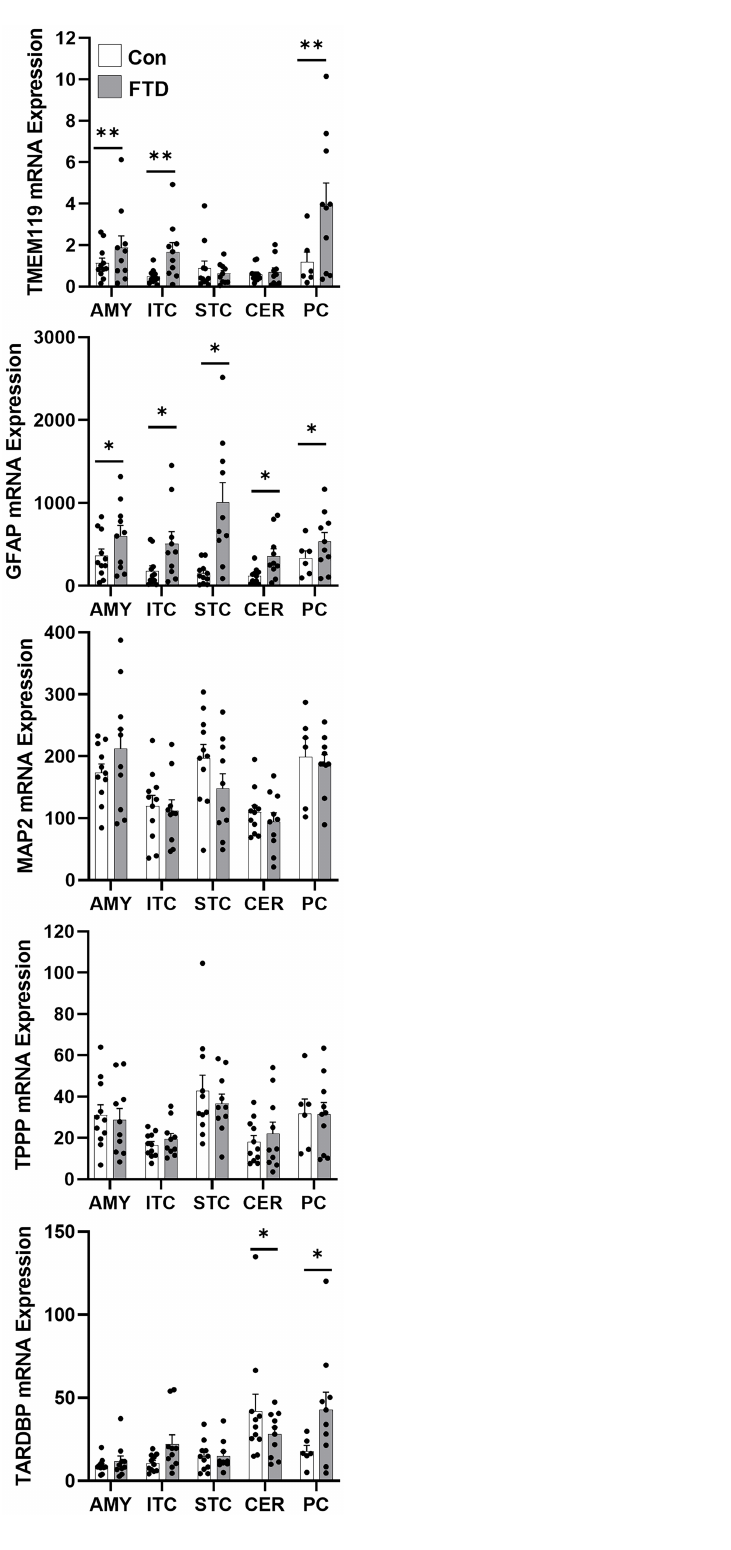
FIGURE 3 mRNA expression of TARDBP and neural markers in FTLD-TDP and control brain. mRNA expression of TARDBP and neural markers, TMEM119 (microglia), GFAP (astrocytes), MAP2 (neurons) and TPPP (oligodendrocytes) in amygdala (AMY), inferior temporal cortex (ITC), superior frontal cortex (SFC), cerebellum (CER) and parietal cortex (PC) in FTLD-TDP and control brain as measured by qPCR. Data represent mean and SE as error bars, * p < 0.05 and ** p <